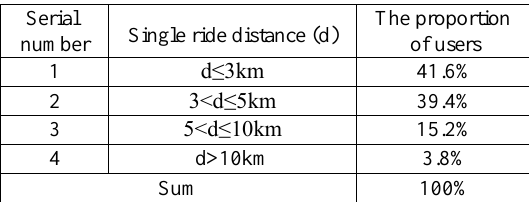
Table 1. Bike-sharing user single riding distance statistics According to Table 1, the dockless bike-sharing stations can be divided into the following three